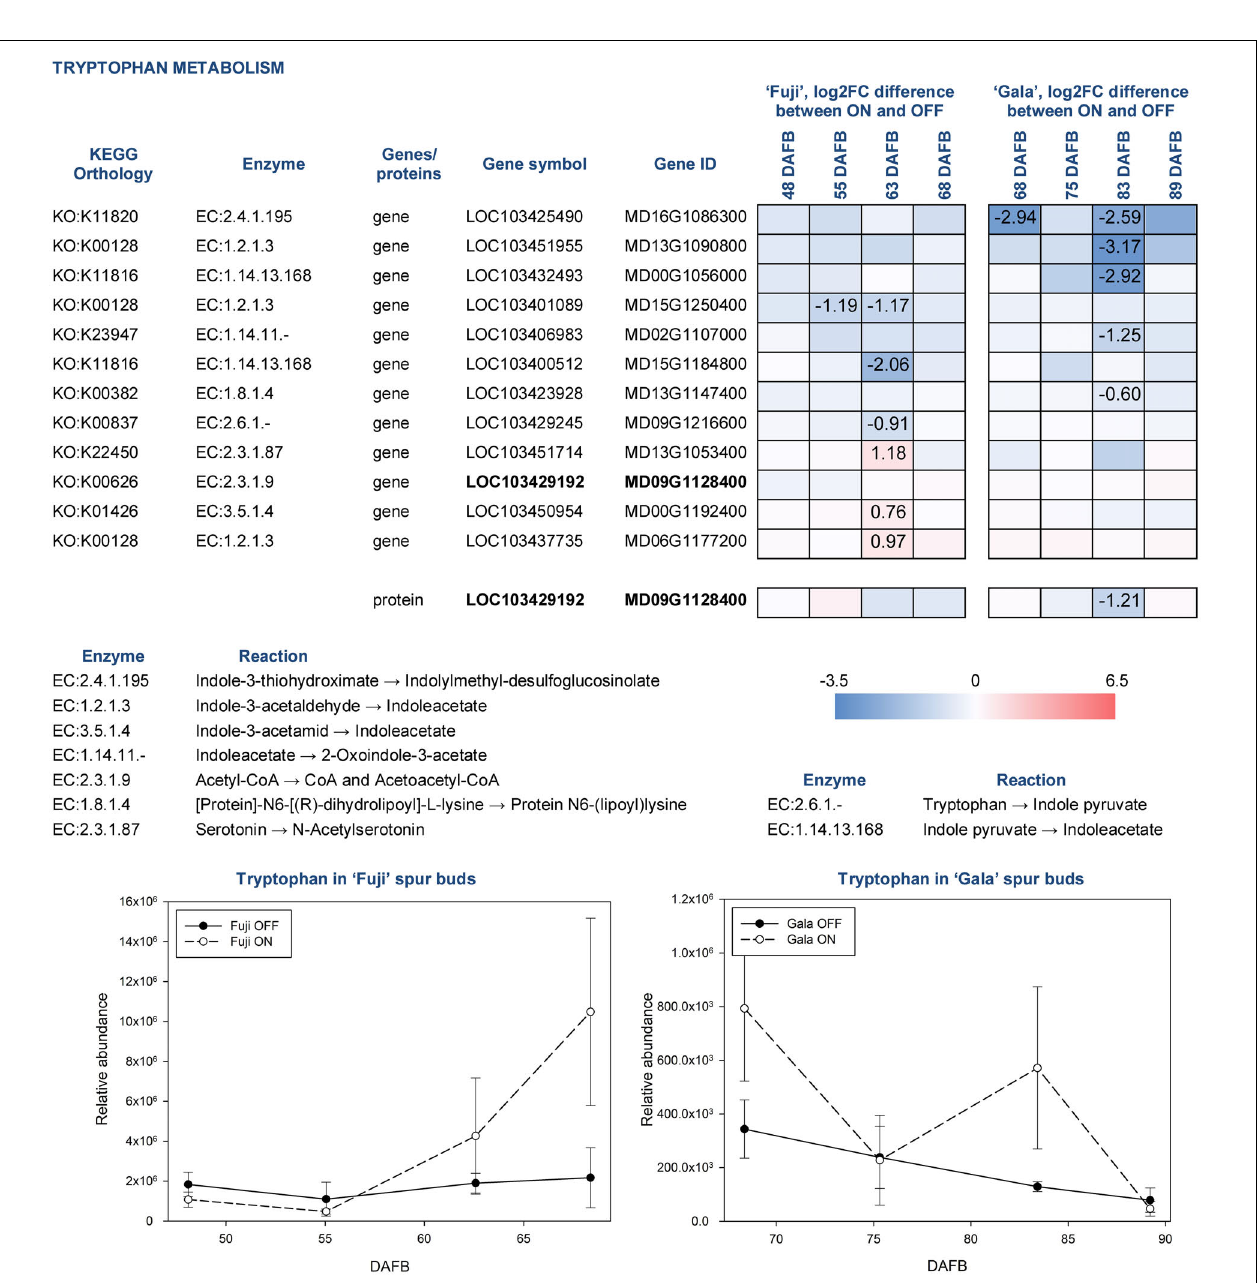
FIGURE 9 | Relative abundance of tryptophan in spur buds from ‘Fuji’ and ‘Gala’ with differently expressed genes (DEGs) between ON- and OFF-trees and corresponding proteins, which are assigned to the indoleacetate biosynthesis. For detailed figure explanation see Figure 7